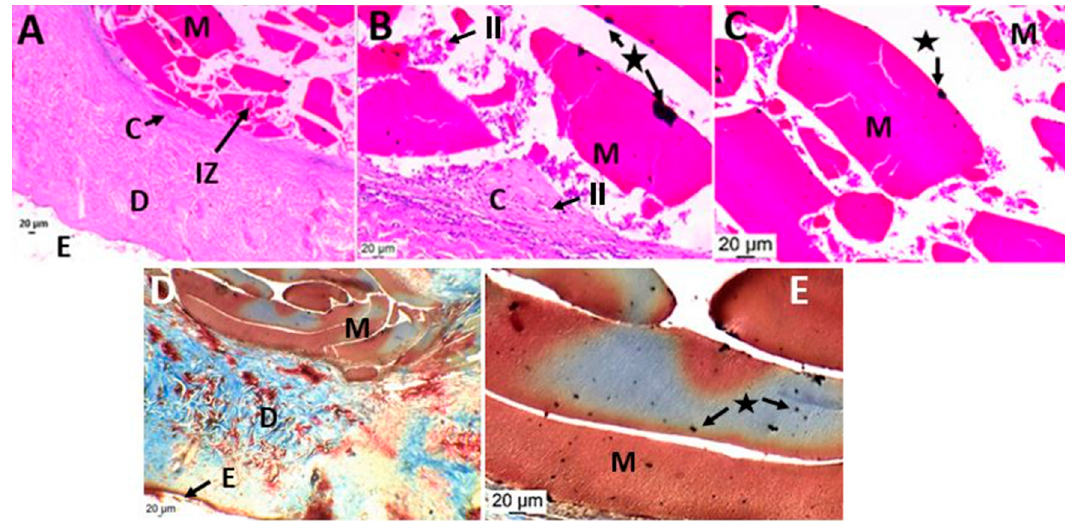
Figure 10. Histological analysis of experimental sample F2 (29.25 CS/70 PVA/0.25 ox-CNO).